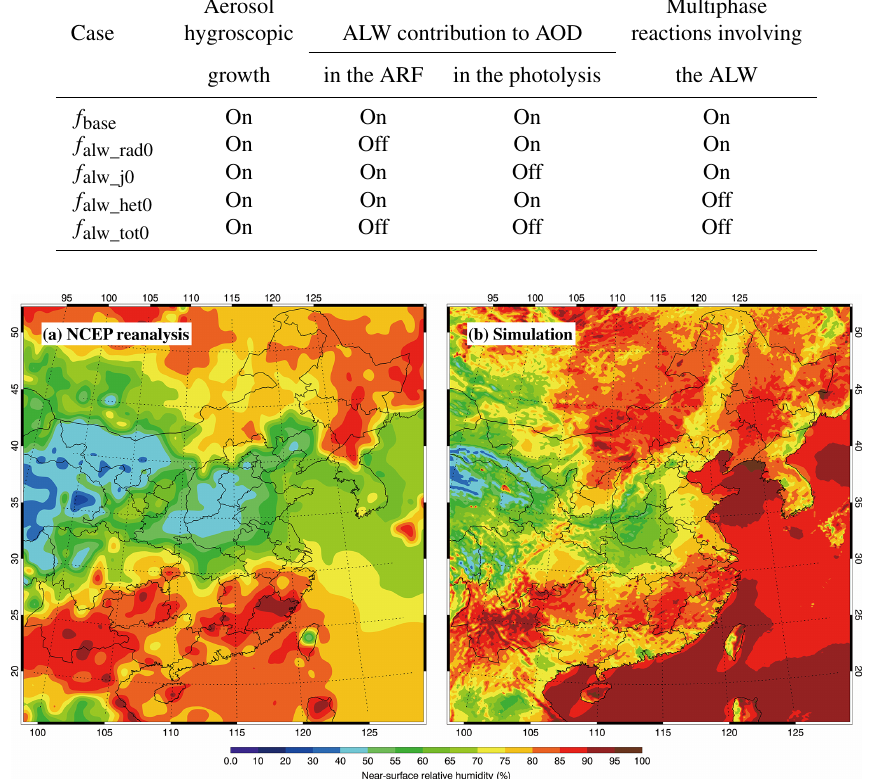
Figure 4. Spatial distribution of (a) NCEP reanalysis and (b) simulated RH averaged from 5 December 2015 to 4 January